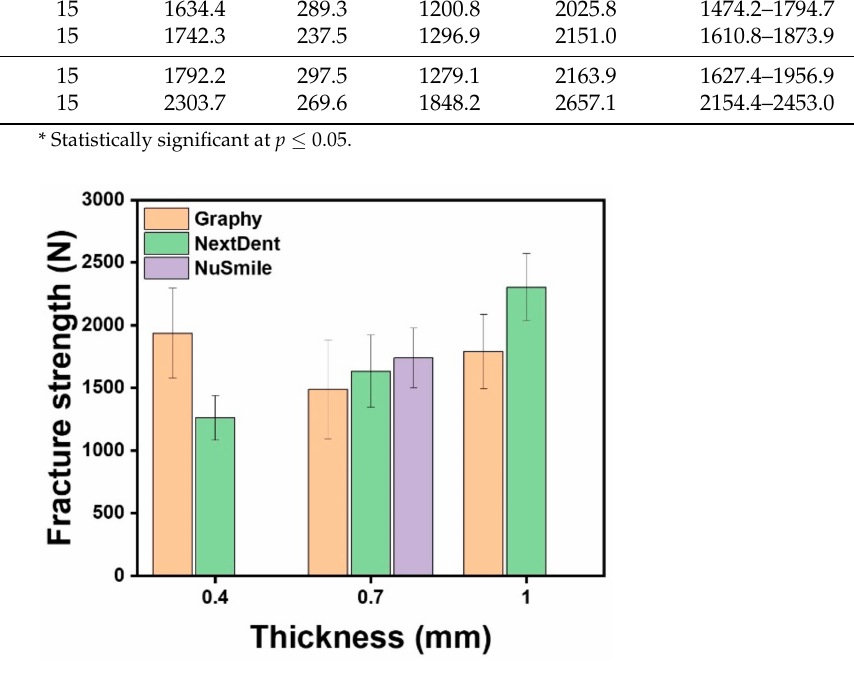
Figure 3. Mean fracture resistance of the various experimental groups according to